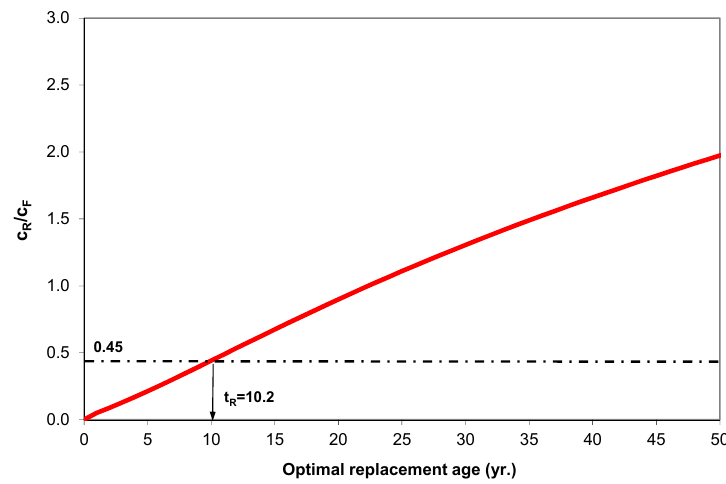
Figure 8. Age replacement policy based for replacement / failure cost ratio = 0.45.